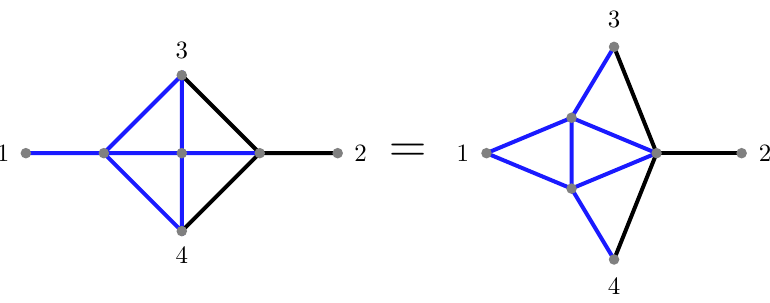
Figure 8 . Conformal magic identity: the three-loop ladder (left panel) and the tennis court (right panel) can be shown to be identical off-shell by using the conformal invariance of the highlighted two-loop ladder